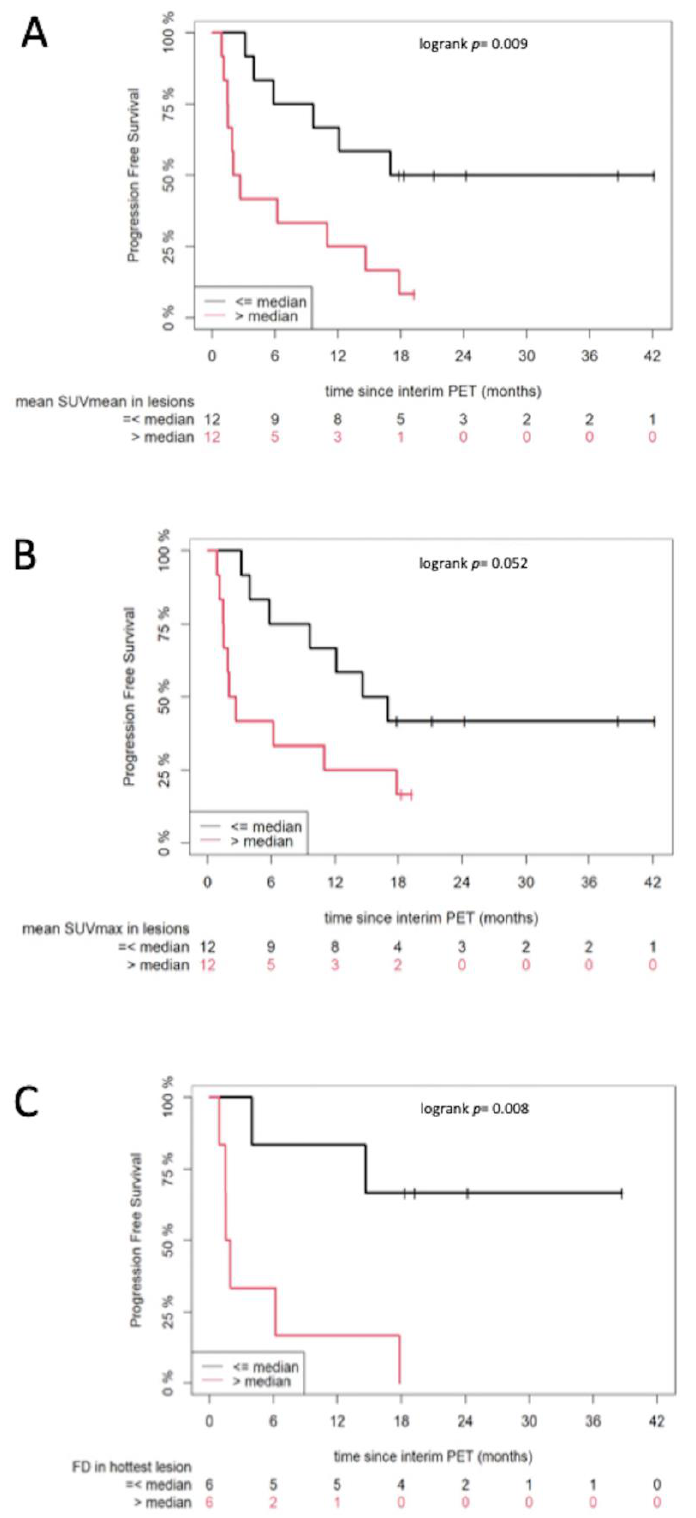
Figure 1. Kaplan–Meier estimates of progression-free survival (PFS) according to different parameters derived from interim PET/CT. These parameters are SUV mean ( A ) and SUV max ( B ), derived from the mean value of the hottest melanoma lesions for each patient (up to five lesions), as well as according to FD ( C ), derived from the single hottest melanoma lesion for each patient. The numbers of patients at risk in each group and for the respective time-points are shown below the